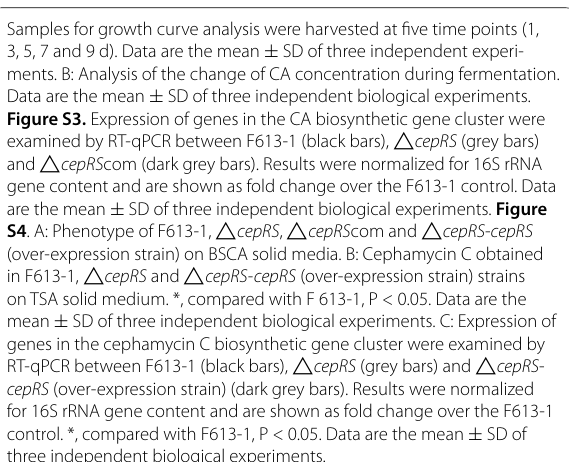
Additional file 1: Table S1. Plasmids and strains used in this study. Table S2. Primers used in this study. Figure S1. (A) Polymerase chain reaction-based verification of the Δ cepS and Δ cepR strains. M: DNA marker. (B) Phenotype of F613-1, △ cepRS , △ cepR , △ cepS and △ cepRS on